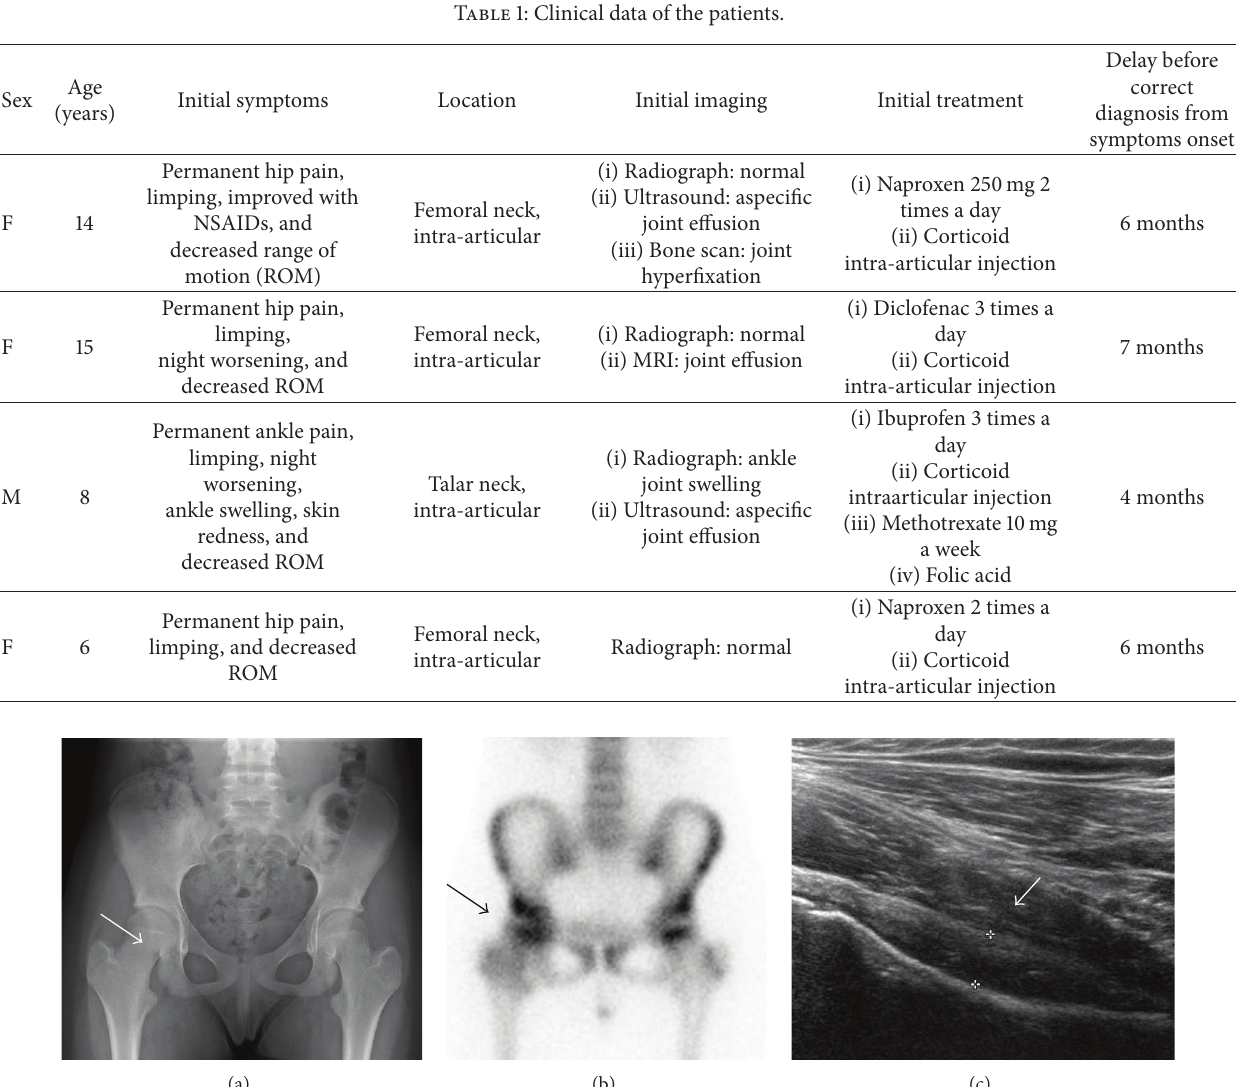
Figure 1: 14-year-old girl with intra-articular osteoid osteoma of the right femoral neck. (a) Frontal X-ray of the pelvis, interpreted as normal. (b) Bone scan, demonstrating increased uptake of the right hip joint. (c) Hip ultrasound, longitudinal scan, showing synovial thickening of the anterior articular recess, right